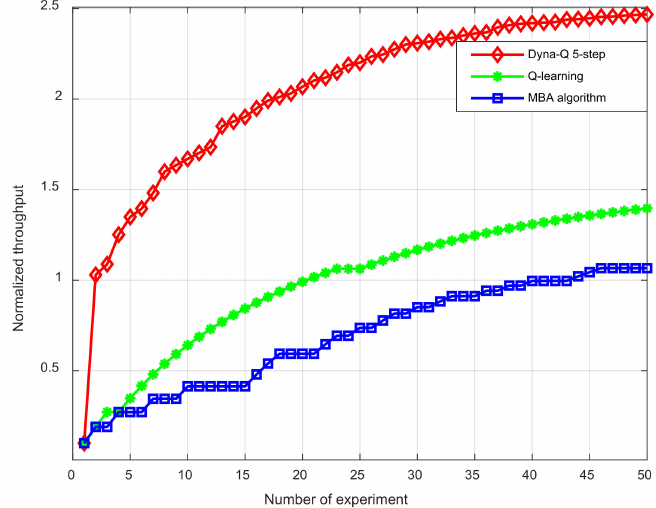
Figure 7. Rewards obtained by different algorithms in each experiment.